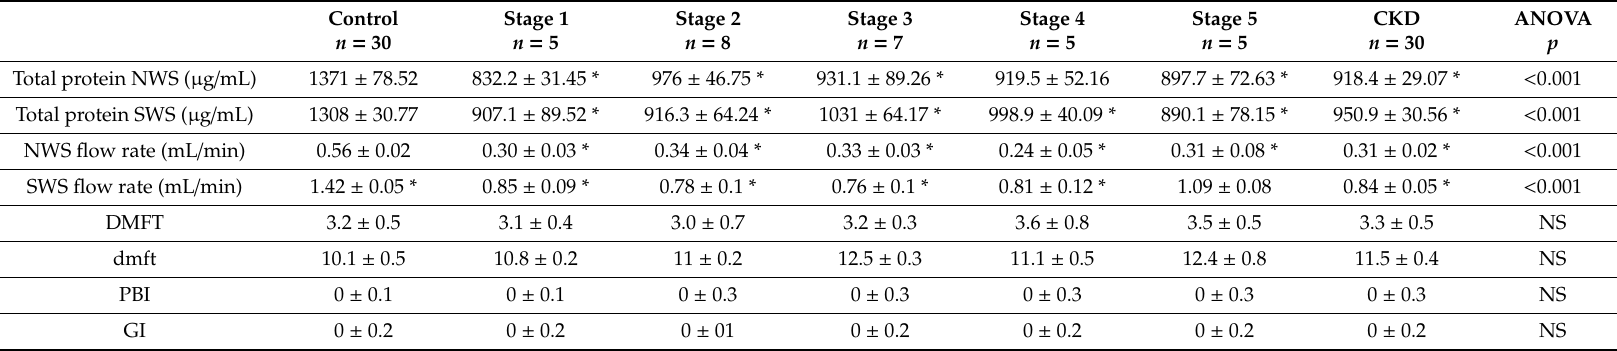
Table 2. Salivary gland function and dental examination of children at di ff erent stages of chronic kidney disease (CKD) and healthy